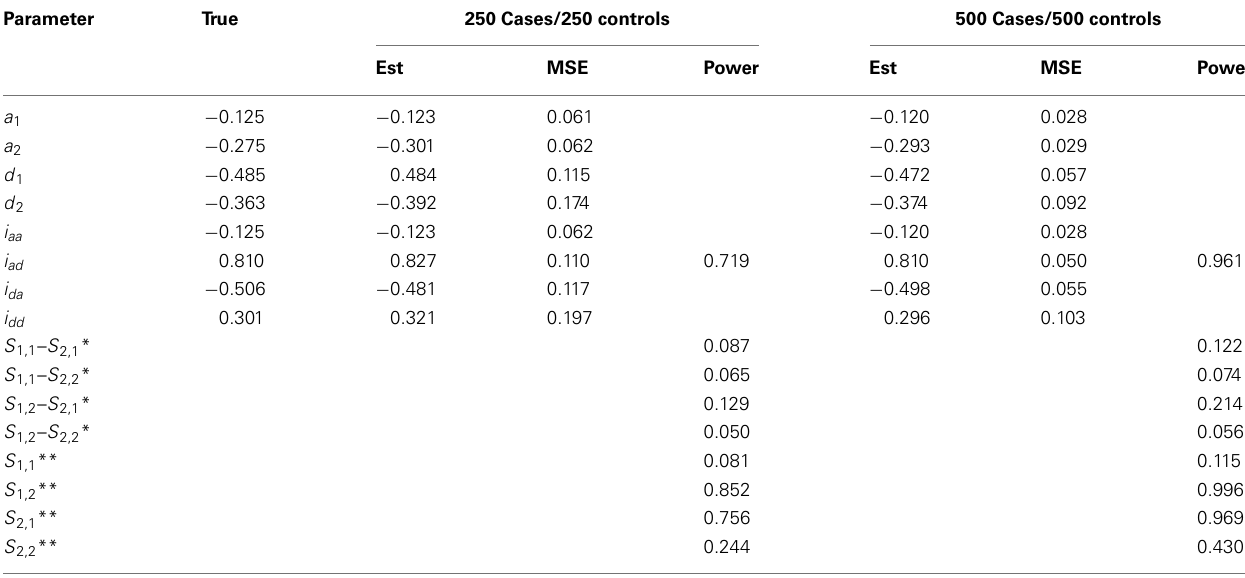
TableA3 | Estimation of genetic parameters and power of epistatic detection from a simulated data for two independent blocks under Scenario 1 for all 1000 simulations.